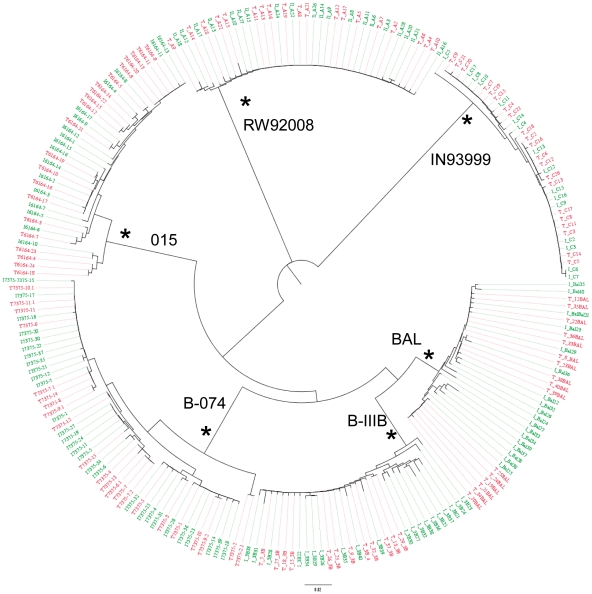
Phylogenetic analysis of all viral inoculum and transmitted pairs.C2-V5 of env nucleotide sequences of the inoculum and transmitted HIV-1 species were aligned for all linked inoculum variants (green lines) and transmitted variants (red lines) and a neighbor-joining tree representing different transmission pairs. Branch lengths are drawn to scale. Viral strain names are shown on the branches, and asterisks are indicated on branches with bootstrap values greater than 99%.